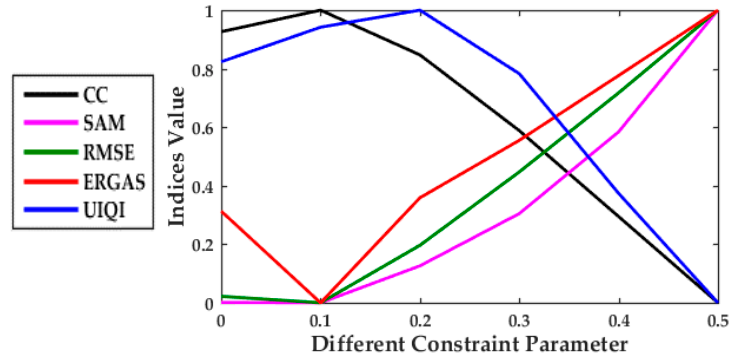
Figure 4. Performance of the proposed method with different α settings.